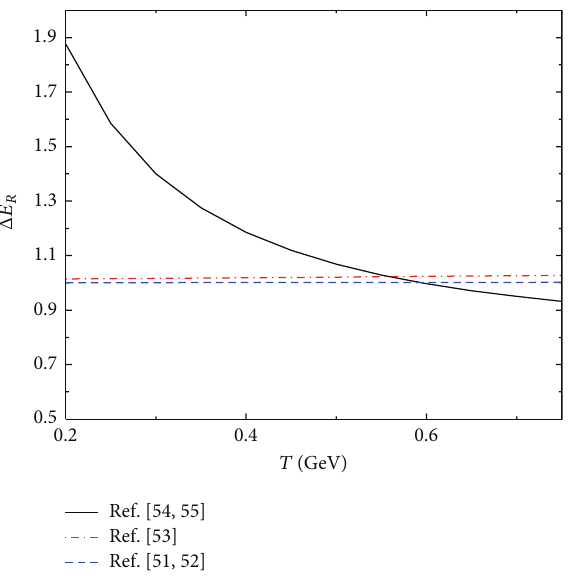
Figure 5: Drag coefficients of charm assuming running strong coupling, 𝛼 𝑠 (𝑇) and temperature dependent Debye screening mass, (𝑇) due to its interaction with thermal gluons, quarks, and 𝑚 𝐷